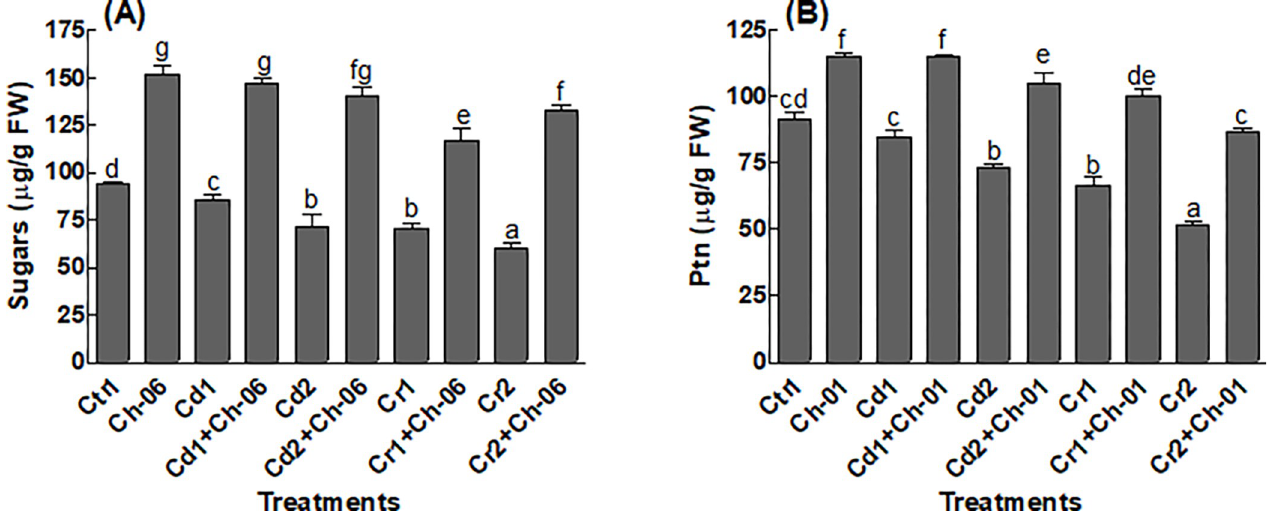
Fig 5. Impact of Ch-06 ( A . violaceofuscus ) on soluble sugar and protein contents of okra under elevated Cd and Cr stress. Co: Control, Cd = cadmium, Cr = chromium, Cd1 and Cr1 = 100 μ g/g, Cd2 and Cr2 = 500 μ g/g. (A): Soluble sugar; (B): Proteins. The data reflect the mean of triplicated data followed by ± SE. The data with different superscript letter are significantly different at P =